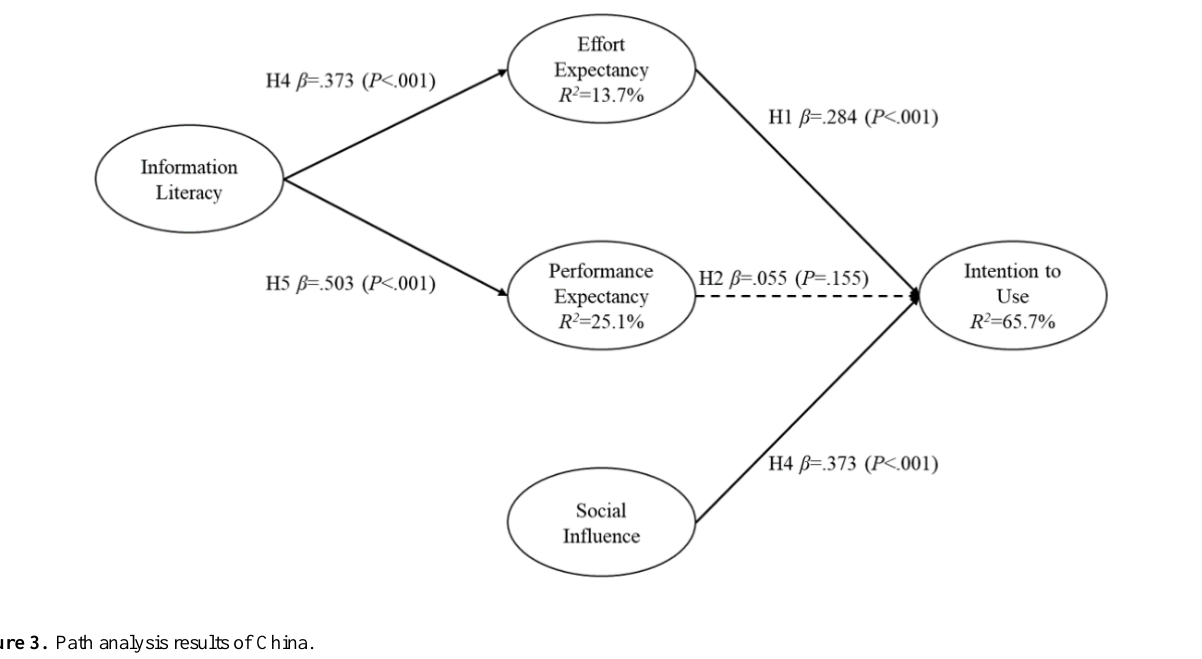
Figure 2. Path analysis results of Taiwan.